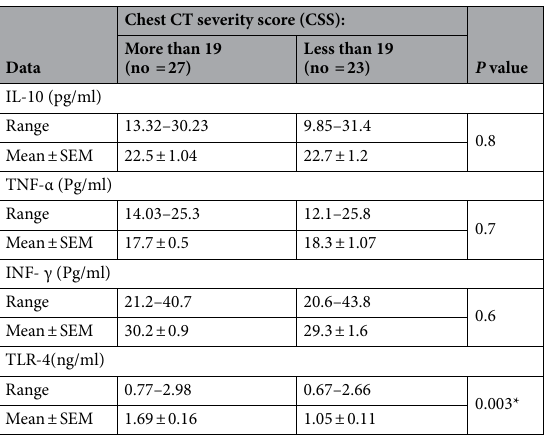
Table 4. The concentration levels of serum IL-10, TNF-α, INF-γ and TLR-4 in relation to the chest CT severity score (CSS). *Significant level at P value < 0.05.